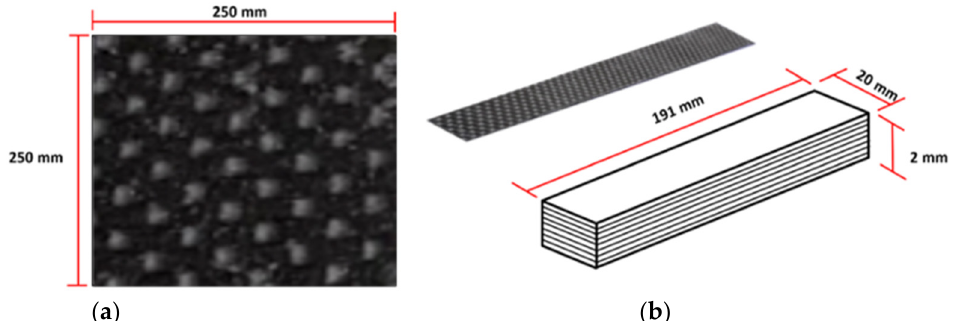
Figure 7. Hybrid composite laminate: ( a ) specimen before cutting; ( b ) cut specimens for the three- point bending test.